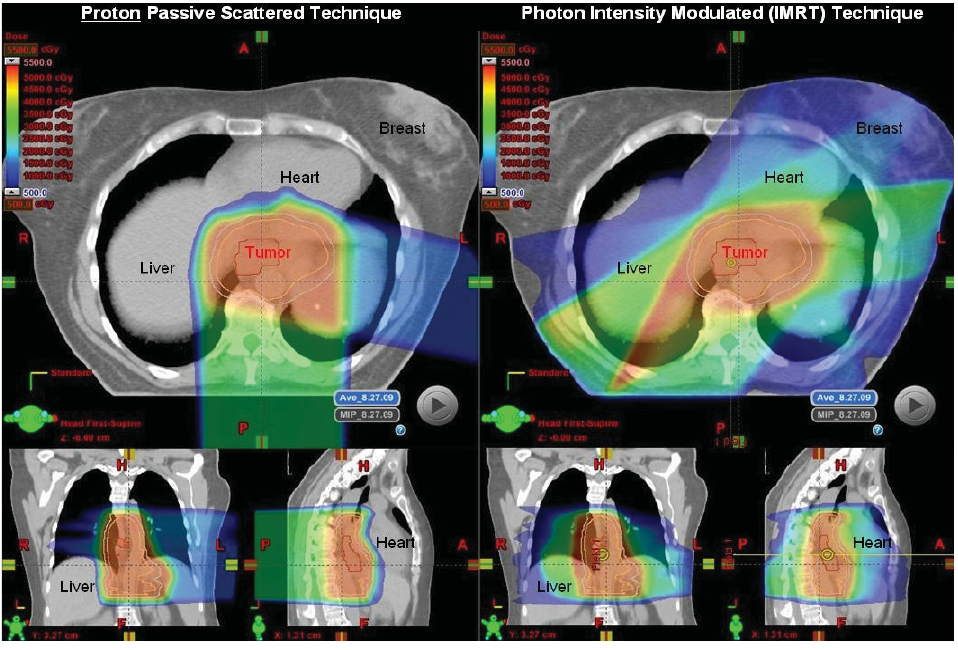
Figure 1. Comparison plans of IMRT and Passive Scattering Proton Beam Therapy for the treatment of distal esophageal cancer. ( A ). Dosimetric comparison of a five field modified firefly IMRT technique (right panel) with a two field passive-scattering proton plan (left panel) is made. Note the relative amount of normal tissue spared of scattered doses of radiation in the proton plan compared to the optimized IMRT plan; ( B ). Quantitative differences in the dose to normal structures and target volumes between PBT and IMRT plans in 20 matched esophageal cancer